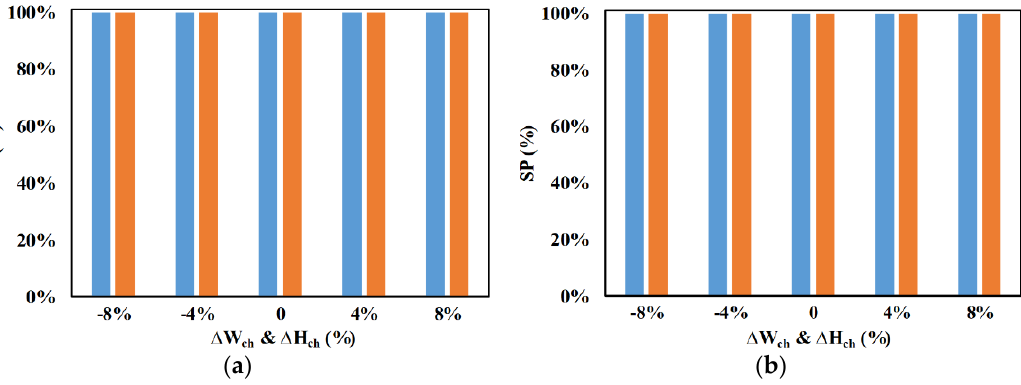
Figure 13. Effect of variations in width and height on SE and SP for ( a ) ■ 2 μm and ( b ) ■ 2.25 μm ( d f = 60 μm, l f = 120 μm, d s = 60 μm, l s = 120 μm, w f = 6 μm, w s = 6 μm, n f = 200, n s = 200, V 1 = 3 V pp , V 2 = 15 V 2 = 15 V pp , V 3 = 15 V pp V 4 = 3 V pp , H ch (at 0%) = 50 µ m, W ch (at 0%) = 50 µ m, 0 < W o ,2.25 < 30 µ m, V pp , V 3 = 15 V pp V 4 = 3 V pp , H ch (at 0%) = 50 μm, W ch (at 0%) = 50 μm, 0 < W o,2.25 < 30 μm, 30 μm < W o,2 < 30 µ m < W o ,2 < 50 µ m, N 1 = N 2 = 10 MHz, N 3 = N 4 = N cr ,2 = 473 kHz). 50 μm, N 1 = N 2 = 10 MHz, N 3 = N 4 = N cr,2 = 473 kHz).